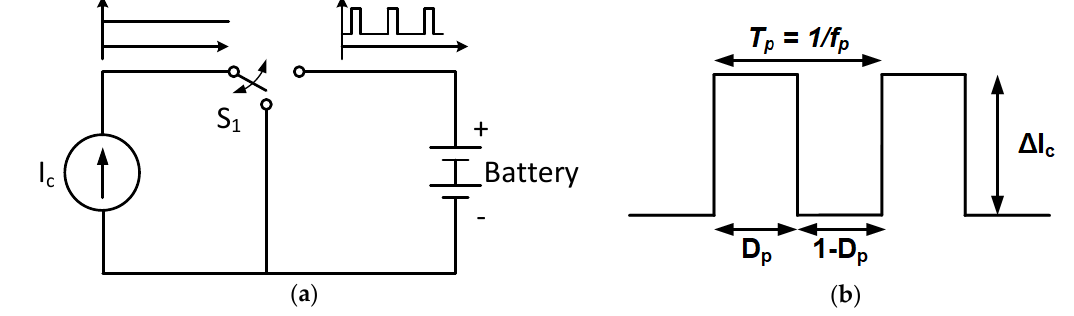
Figure 3. Structure of the pulse charger. ( a ) Pulse charging model and ( b ) pulse waveform.